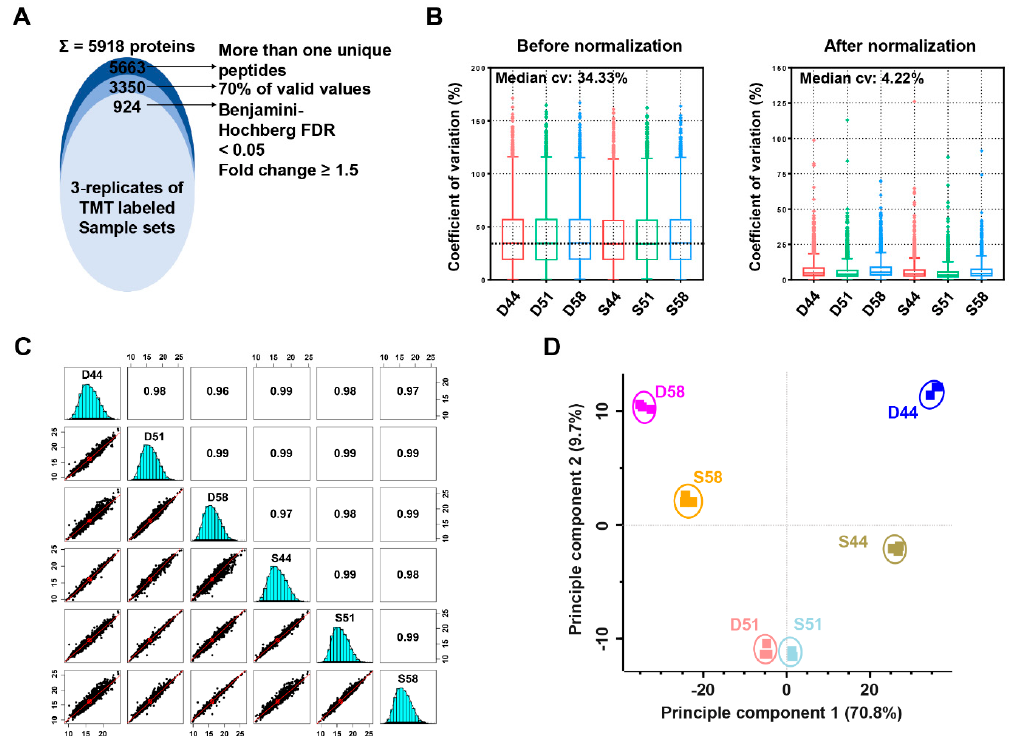
Figure 5. Proteomic analysis of filling stage seed samples by TMT based quantitative approach. ( A ) Venn diagram showing the distribution of total identified and significantly modulated proteins followed by a narrow-down approach among samples. ( B ) The coe ffi cient of variation (CV) values showing the improvement of the quantitative reproducibility of all proteins normalized by the internal reference scaling (IRS) method using boxplot. The median CV values of all the samples decreased from 34.3% to 4.3% following the IRS normalization approach. ( C ) Multi-scatter plot showing the reproducibility across three replicates of each sample reveals with Pearson correlation value. ( D ) Principle component analysis showing clear separation of 924 significantly modulated proteins.